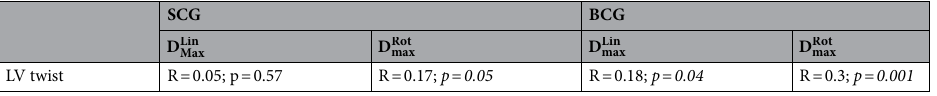
Table 2. Associations of displacements from SCG and BCG with the peak of LV twist from 2D STI echocardiography. Spearman’s correlation of velocities computed from the SCG and BCG signals in both Lin linear and rotational channels with peak of LV twist obtained with 2D STI echocardiography. D max maximal Rot displacement in the linear dimension (mm/m 2 ), D Max maximal displacements in the rotational dimension (°/ m 2 ), BCG ballistocardiograph, SCG seismocardiography.